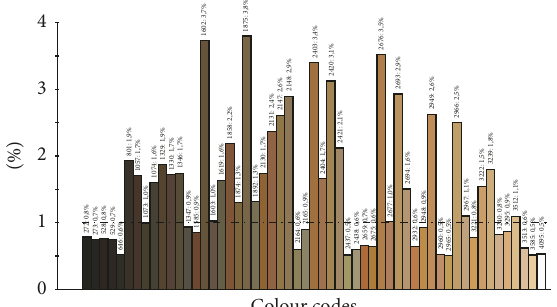
Figure 2: Example of the histogram representation of the colour spectrum of a single FFP’s picture obtained by the use of digital camera (CoolSNAP-Pro colour camera, 6.3x) and analyzed by CVS AlphaSoft software (Alpha MOS, France). On a fixed scale of 4096 colours, the proportion of each colour in the analyzed image is represented as a